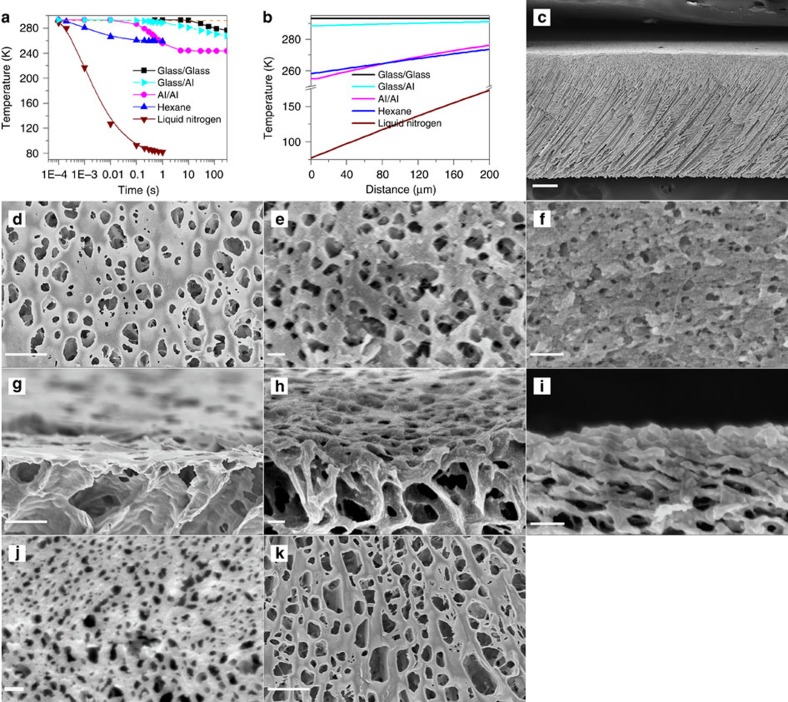
PVDF membranes prepared by the combined crystallization and diffusion method with different cooling rates.(a) Temperature change in the polymer film at the position 10 μm away from the cooling interface; the left of the slash is the material of the cold plate, and the right is the material of the casting plate. The brown dashed line shows the melting point of the solvent DMSO. (b) Temperature profile of the polymer film from the cold end after cooling for 1 s. (c) Cross-sectional SEM image of the Glass/Glass sample. (d–f) Cold-end surface and (g–i) top layer cross-sectional SEM images of the Glass/Glass, Glass/Al, Al/Al sample, respectively. (j) Hexane and (k) liquid nitrogen sample's surface SEM image. The scale bar in c is 100 μm; in d,g,j and k is 2 μm; and in e,f,h and i is 200 nm.